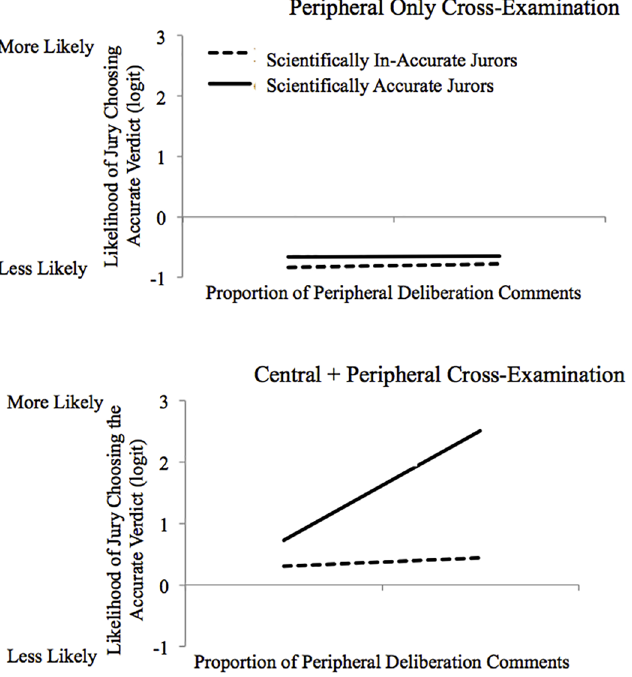
Fig 5. The likelihood of the jury choosing the more accurate verdict as a function of arguments made during deliberation.